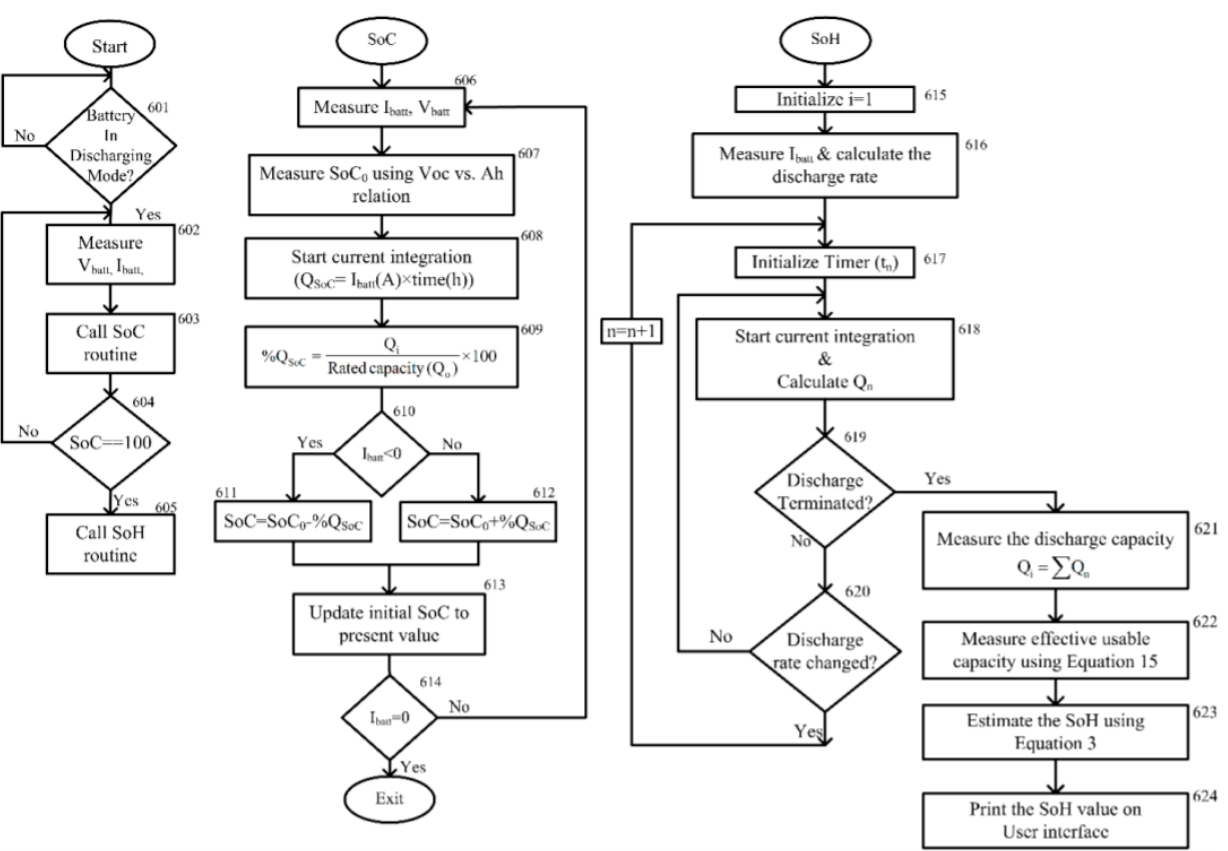
Figure 10. Flowchart for SOH estimation.